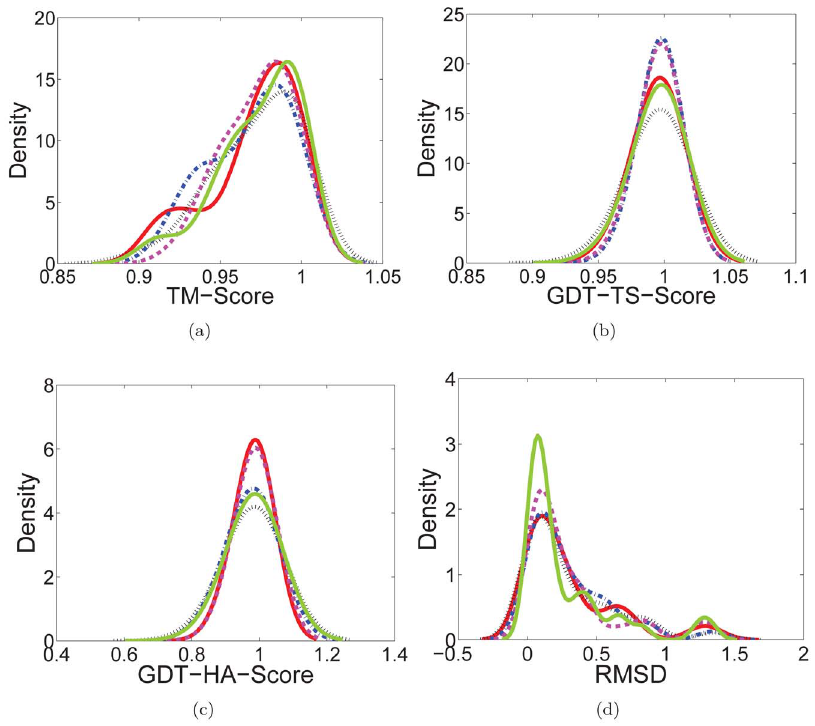
Figure 9. The kernel smoothing density estimate of (a) TM-Score, (b) GDT-TS-Score, (c) GDT-HA-Score, and (d) RMSD achieved over the native constrains. AdaFa- S 1 –AdaFa- S 5 were represented by red solid line, black dotted line, blue dotted dashed line, magenta dashed line, and green solid line, respectively. doi:10.1371/journal.pone.0112634.g009 PLOS ONE |